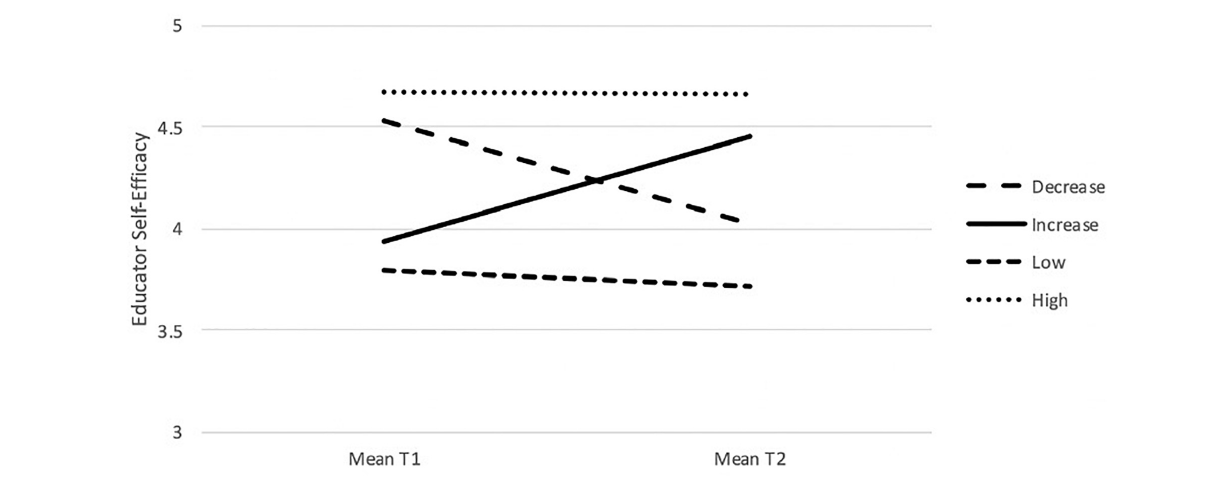
favours the full model instead of the models with fewer predictors (full model: Nagelkerke R 2 =